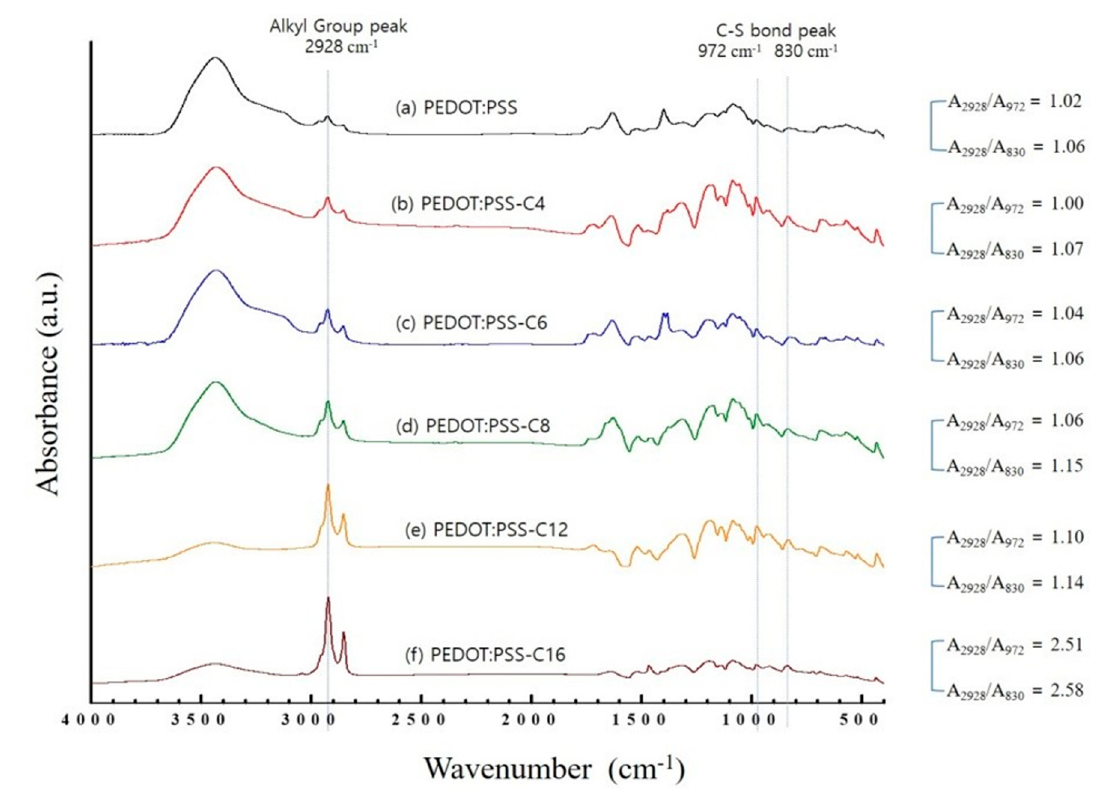
Figure 3. FT-IR spectra of PEDOT:PSS and Figure 3. FT - IR spectra of PEDOT:PSS and derivatives.